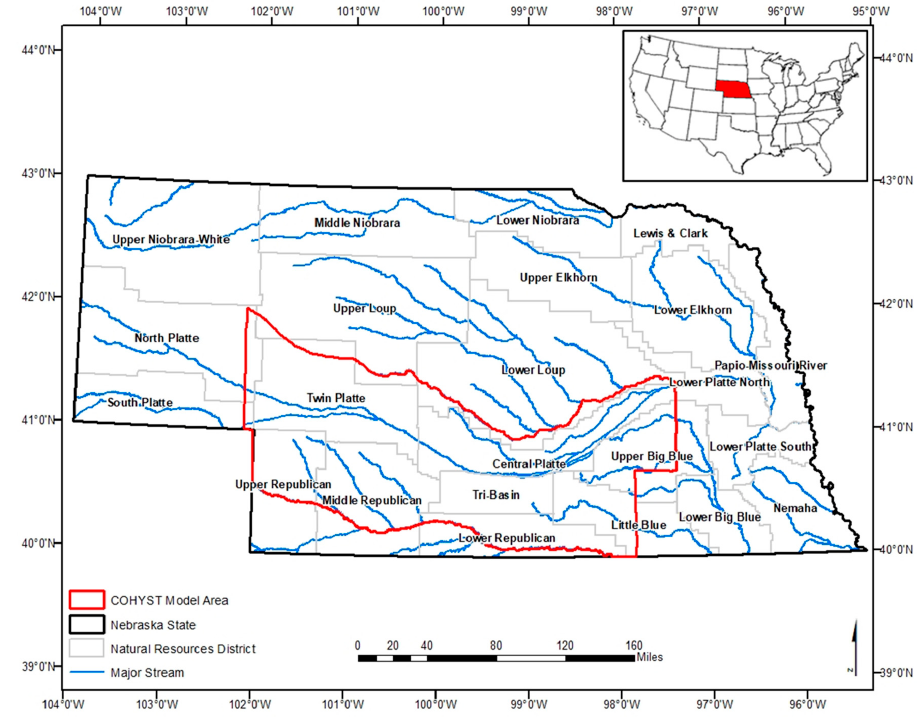
Figure 1. Map of Nebraska showing the Cooperative Hydrology Study (COHYST) hydrological model region, Rivers, and Natural Resources Districts (NRDs).